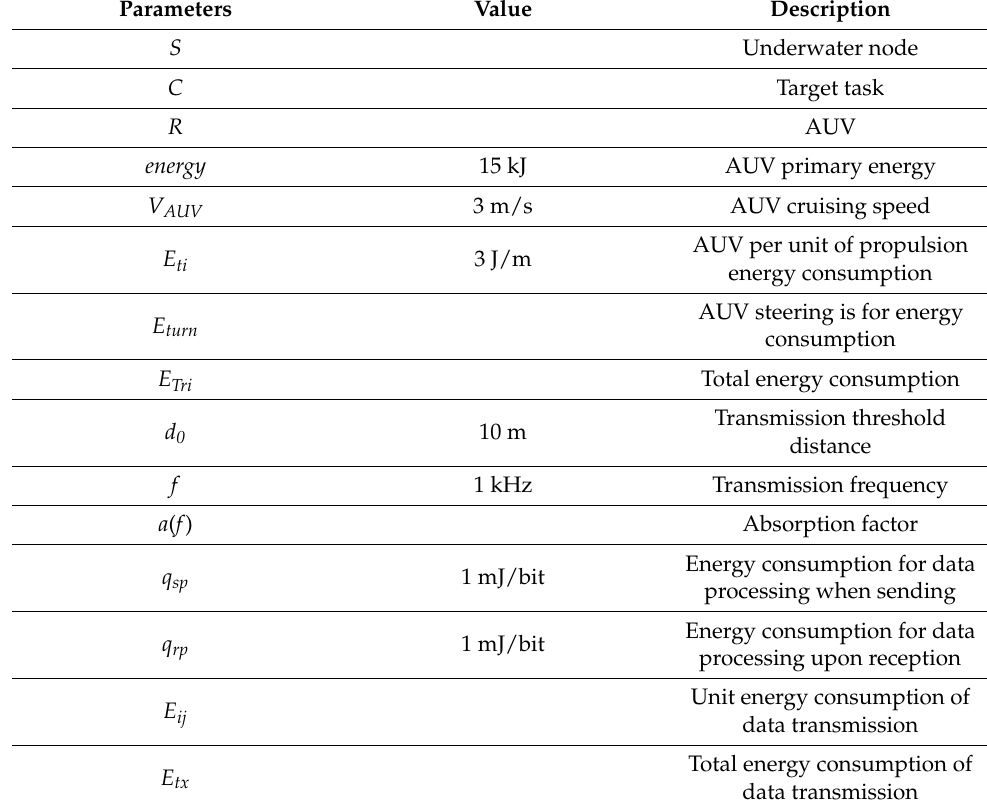
Table 1. Control parameters.